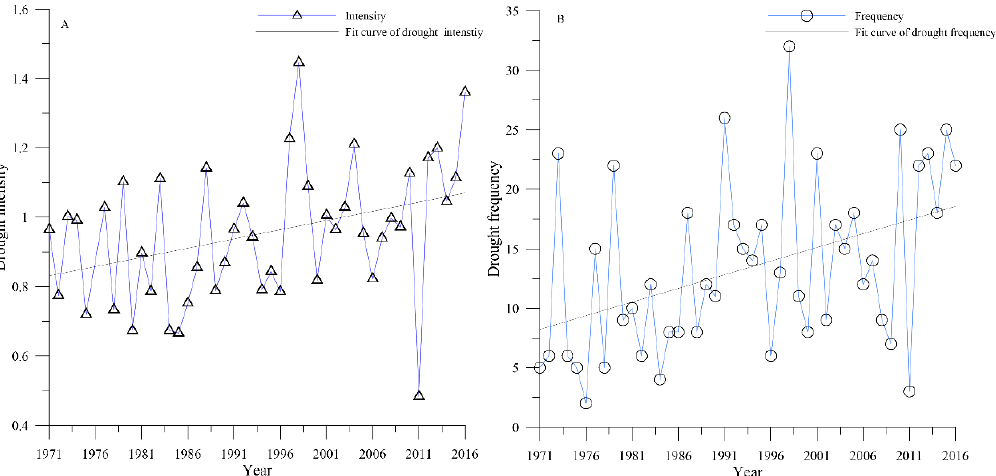
Figure 5. Variation in ( A ) drought intensity and ( B ) frequency over the Mun River Basin from 1971 to 2016.